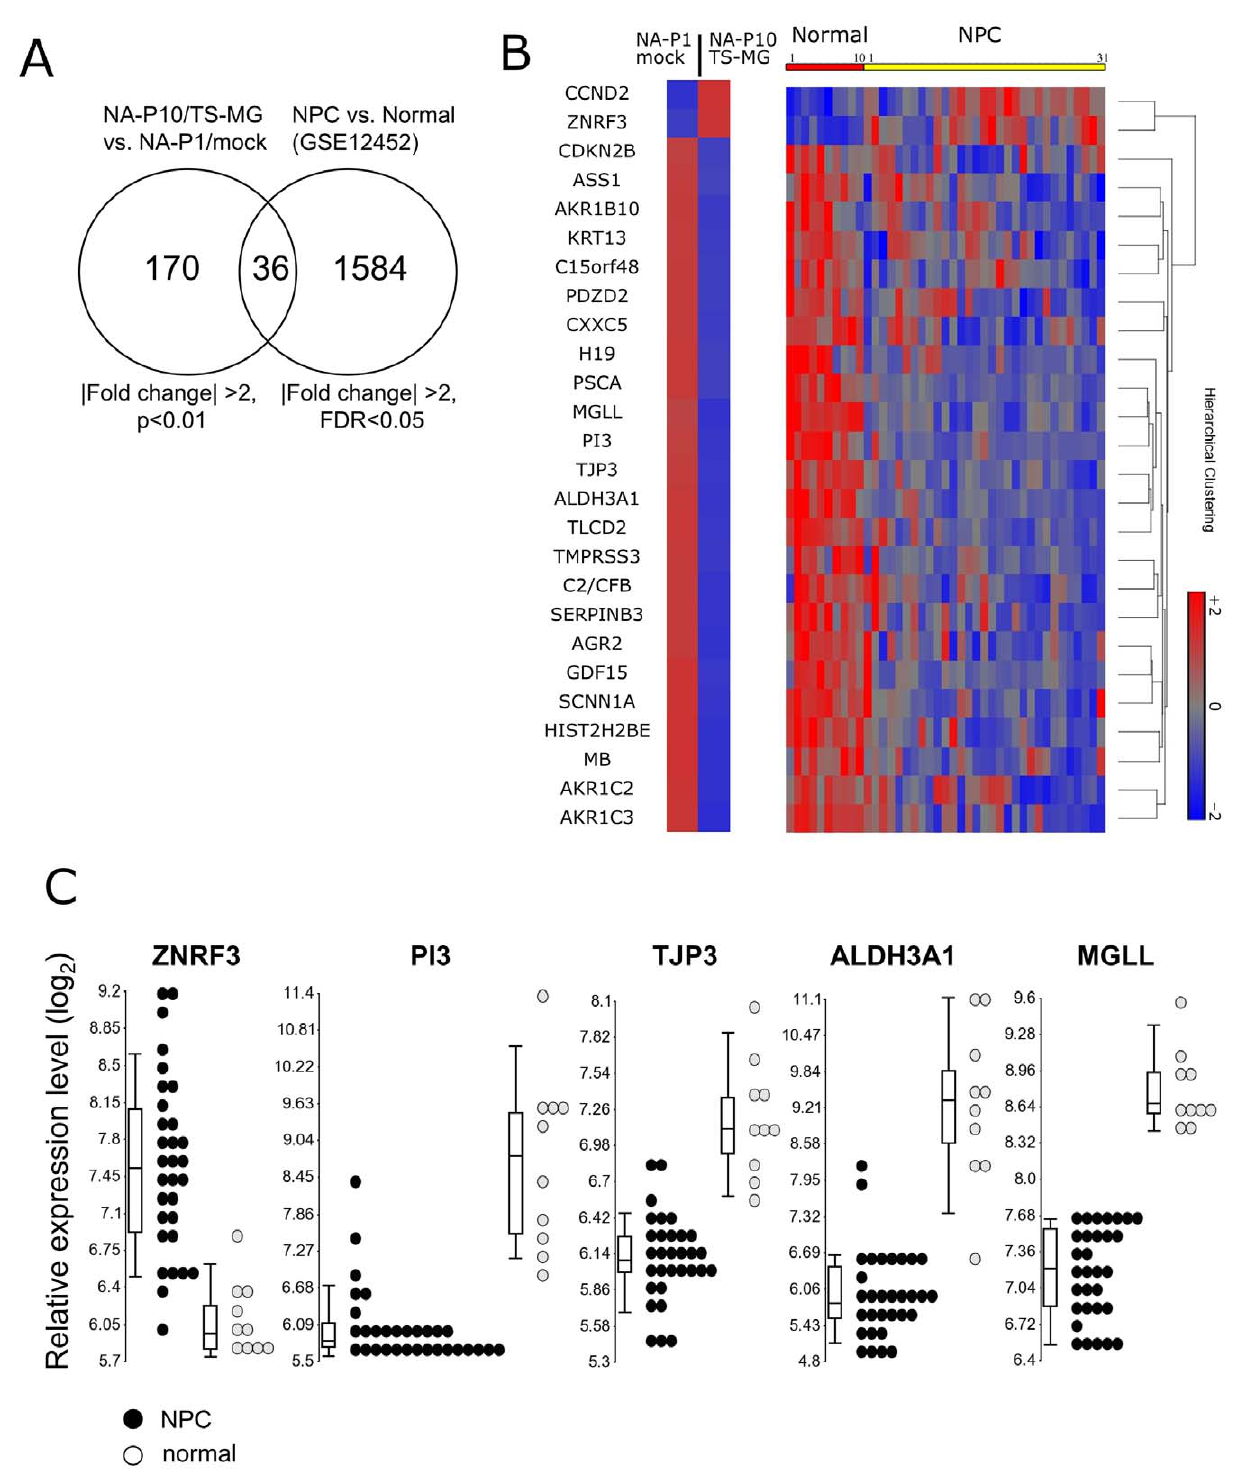
Figure 5. Differentially expressed genes in NPC cells after recurrent EBV reactivation corresponded to the alterations observed in NPC biopsies. (A) Differentially expressed probe sets of NA-P10/TS-MG and NA-P1/mock, and 31 NPC and 10 normal biopsies (GSE12452). The intersection between two data sets yielded a 36 common probe set which was presented in both groups. (B) Expression profile of 28 genes (derived from the 36 common probes) that were differentially expressed in NPC cell lines and biopsies. Hierarchical clustering was performed by shifting genes to mean of zero and scale to standard deviation of one. (C) Expression profile of five carcinogenesis-related genes in 31 NPC and 10 normal biopsies. Each circle represents the expression level of an individual biopsy. Boxplot indicates the median (central band) and the 10th and 90th percentile (lower and upper whiskers, respectively) of expression level. ZNRF3: zinc and ring finger 3; PI3: peptidase inhibitor 3, skin-derived; TJP3: tight junction protein 3; ALDH3A1: aldehyde dehydrogenase 3 family, member A1; MGLL: monoglyceride